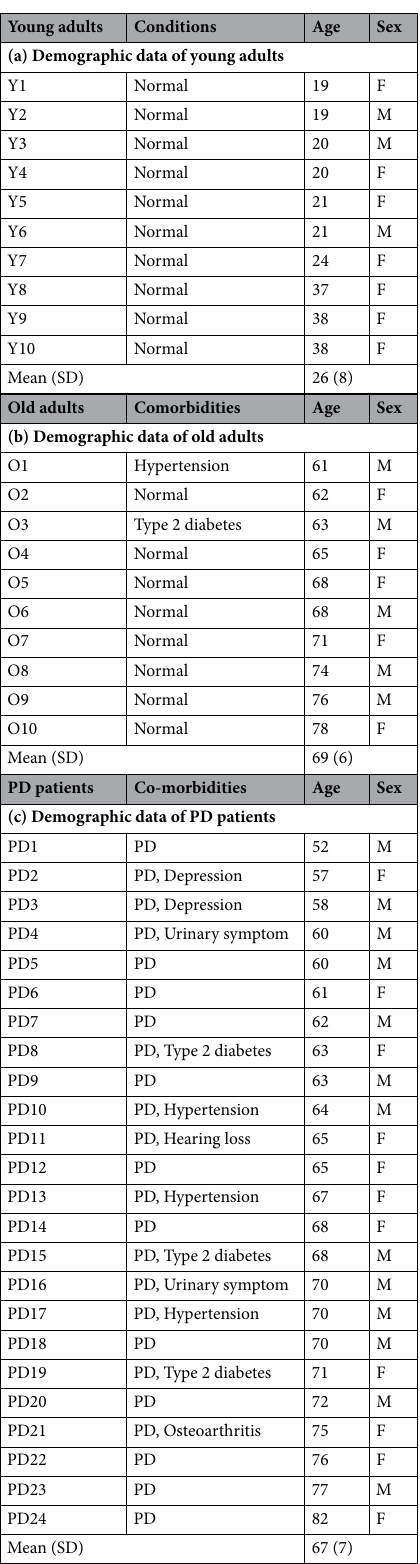
Table 1. Demographic data of the subjects studied. PD Parkinson disease, M male, F female, SD standard